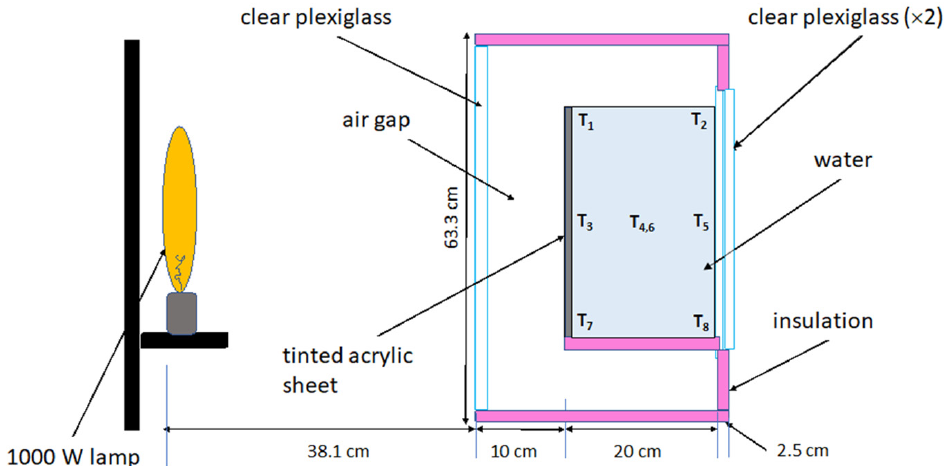
Figure 3. Schematic of the experimental setup showing the location of the thermocouples inside the water storage medium.